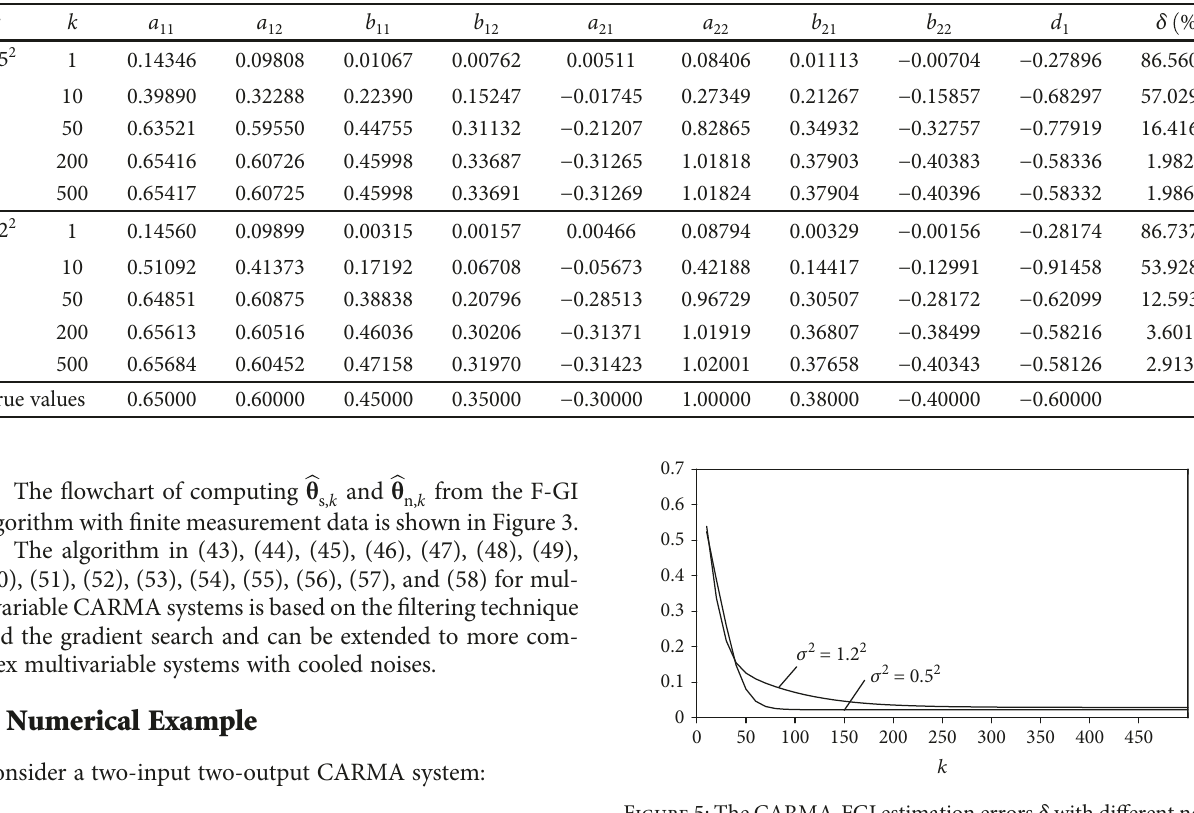
Table 2: The F-GI parameter estimates and errors ( L = 2000 ).